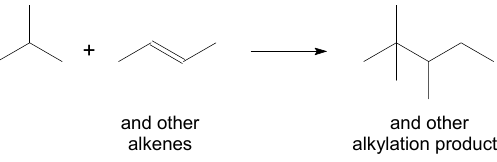
Figure 4. Aliphatic alkylation, illustrated by the reaction of isobutane and trans -2-butene. The nature of the alkene will influence the structure of the alkylation product.